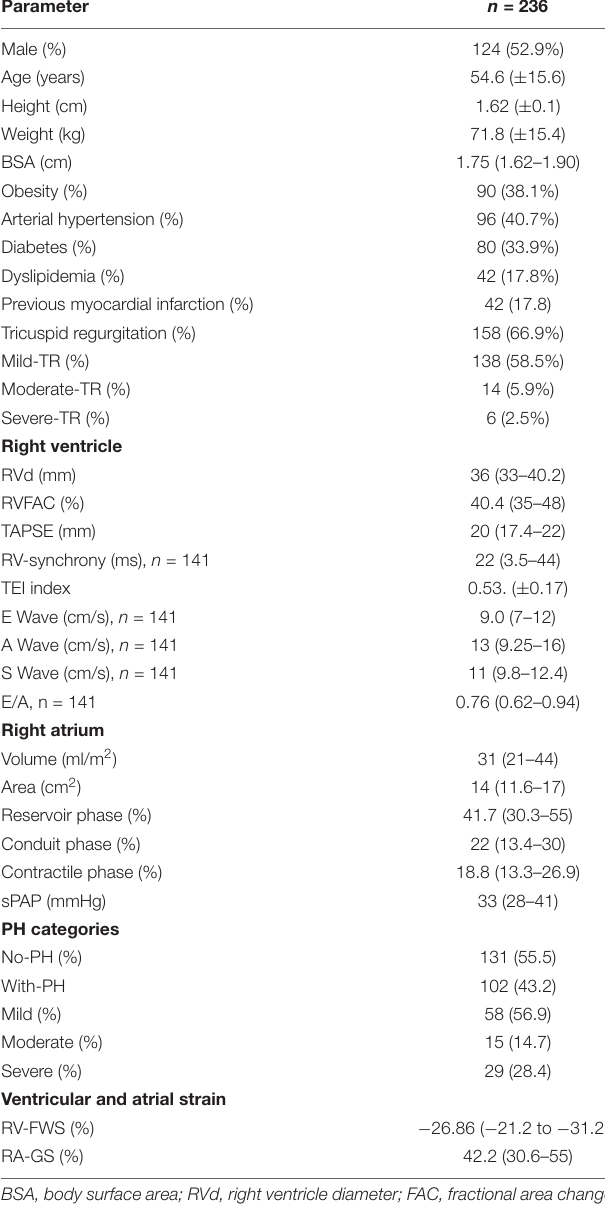
TABLE 1 | Demographic and echocardiography assessment of study